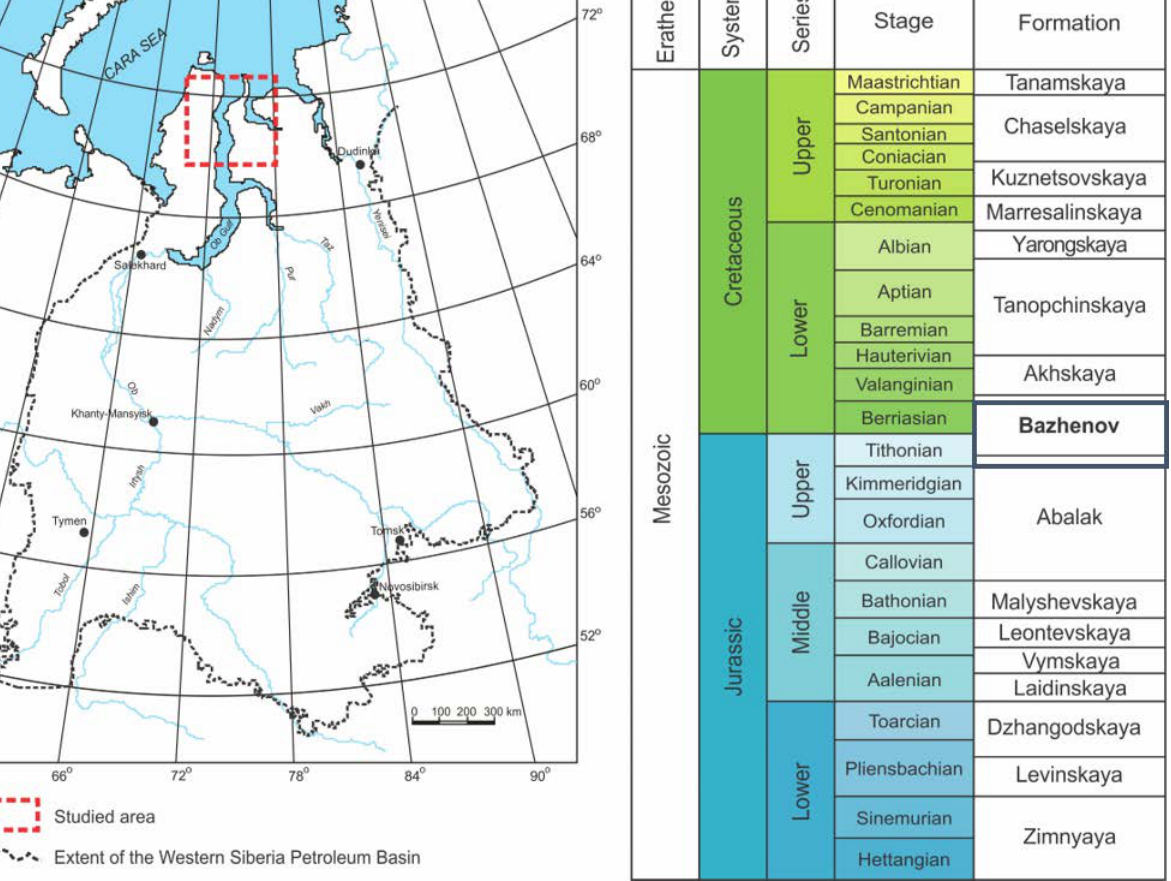
Figure 1. Location of the studied area (modified after Zanin [4]) and stratigraphy of Mesozoic deposits (modified after Afanasenkov [14]); the investigated stratigraphic interval is marked by